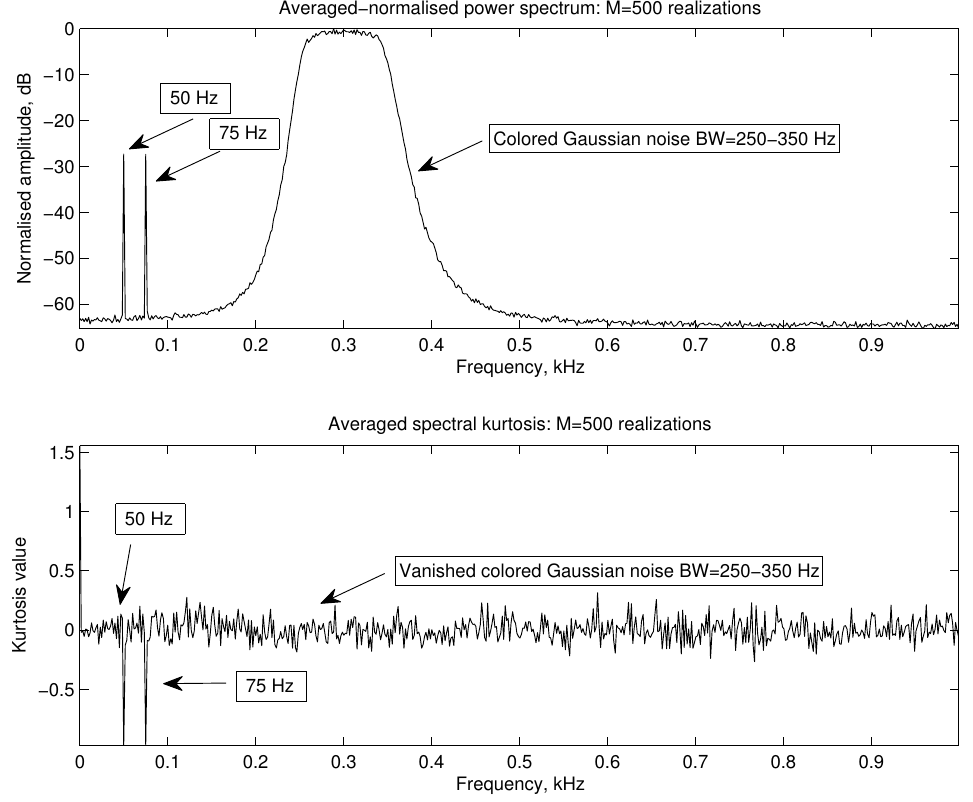
Figure 9. Harmonics’ discrimination and noise rejection. Harmonics at 50 and 75 Hz have been mixed with colored Gaussian noise ( σ = 0 . 05 , bandwidth: 250 to 350